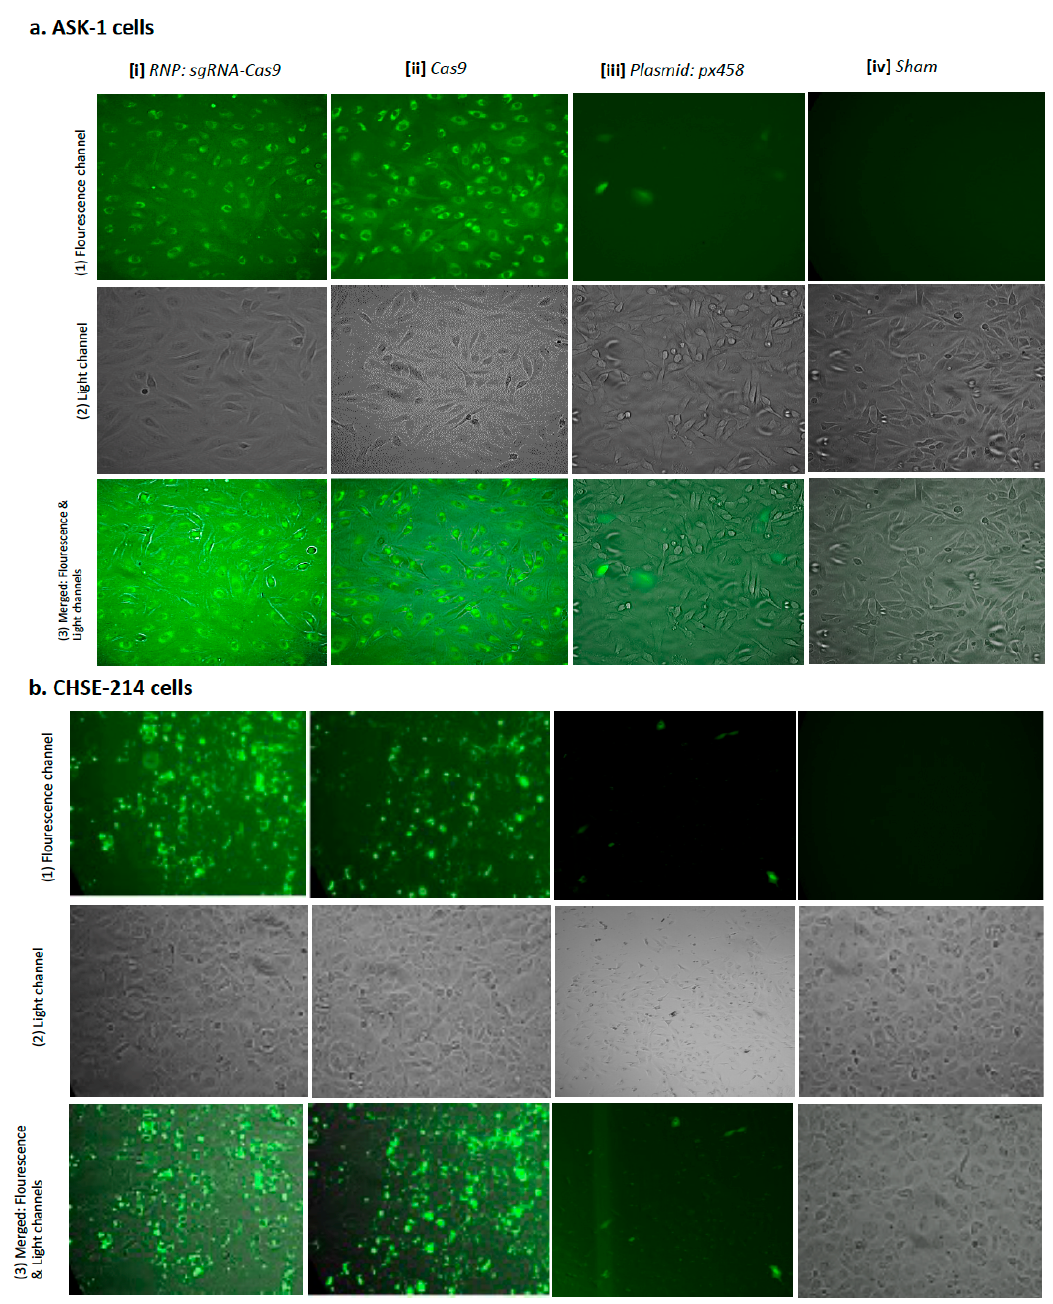
Figure 2 . Ribonucleoprotein (RNP) and plasmid (px458) transfection of ( a ) ASK-1 and ( b ) CHSE-214 cells. Vertical panels show cells transfected with (i) RNP (sgRNA:Cas9-EGFP complex); (ii) Cas9- EGFP protein control; (iii) plasmid (px458); (iv) sham control. Horizontal panels show pictures of cells taken with (1) fluorescent channel; (2) light channel; (3) overlay of the light and fluorescent panels. Pictures were taken at day 7 after RNP electroporation (1600 V, 10 ms, 3 pulses) and day 2 after px458 electroporation (1200 V, 20 ms, 2 pulses). Strong adherence of Cas9-EGFP was observed on the cell surface of CHSE-214, and it was difficult to entirely wash off with PBS, explaining the high background fluorescence in the Cas9-EGFP- and RNP-transfected CHSE-214 cells. Magnification X20. (Fluorescent pictures of transfected SHK-1 cells are not shown).